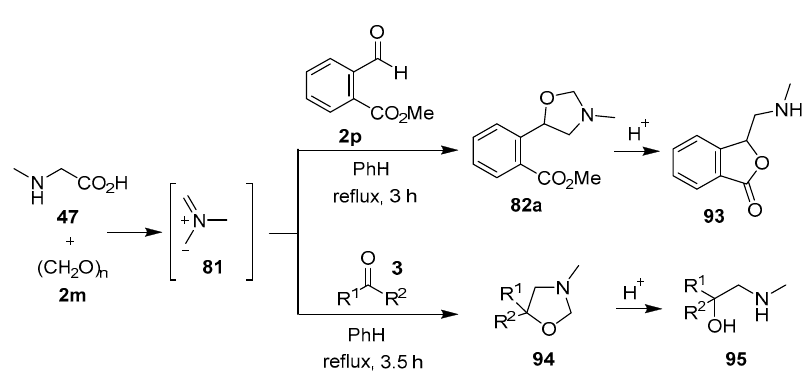
oxazolidine ring-opened products. Table 12. Cycloaddition of azomethine ylide 81 to ketones 3 (Scheme 21). Table 12. Cycloaddition of azomethine ylide 81 to ketones 3 (Scheme 21). Entry Table 12. Cycloaddition of azomethine ylide 81 to ketones 3 (Scheme 21). Table 12. Cycloaddition of azomethine ylide 81 to ketones 3 (Scheme 21). Table 12. Cycloaddition of azomethine ylide 81 to ketones 3 (Scheme 21). Table 12. Cycloaddition of azomethine ylide 81 to ketones 3 (Scheme 21). Table 12. Cycloaddition of azomethine ylide 81 to ketones 3 (Scheme 21). Table 12. Cycloaddition of azomethine ylide 81 to ketones 3 (Scheme 21). Table 12. Cycloaddition of azomethine ylide 81 to ketones 3 (Scheme 21). Entry Entry Entry Entry Entry